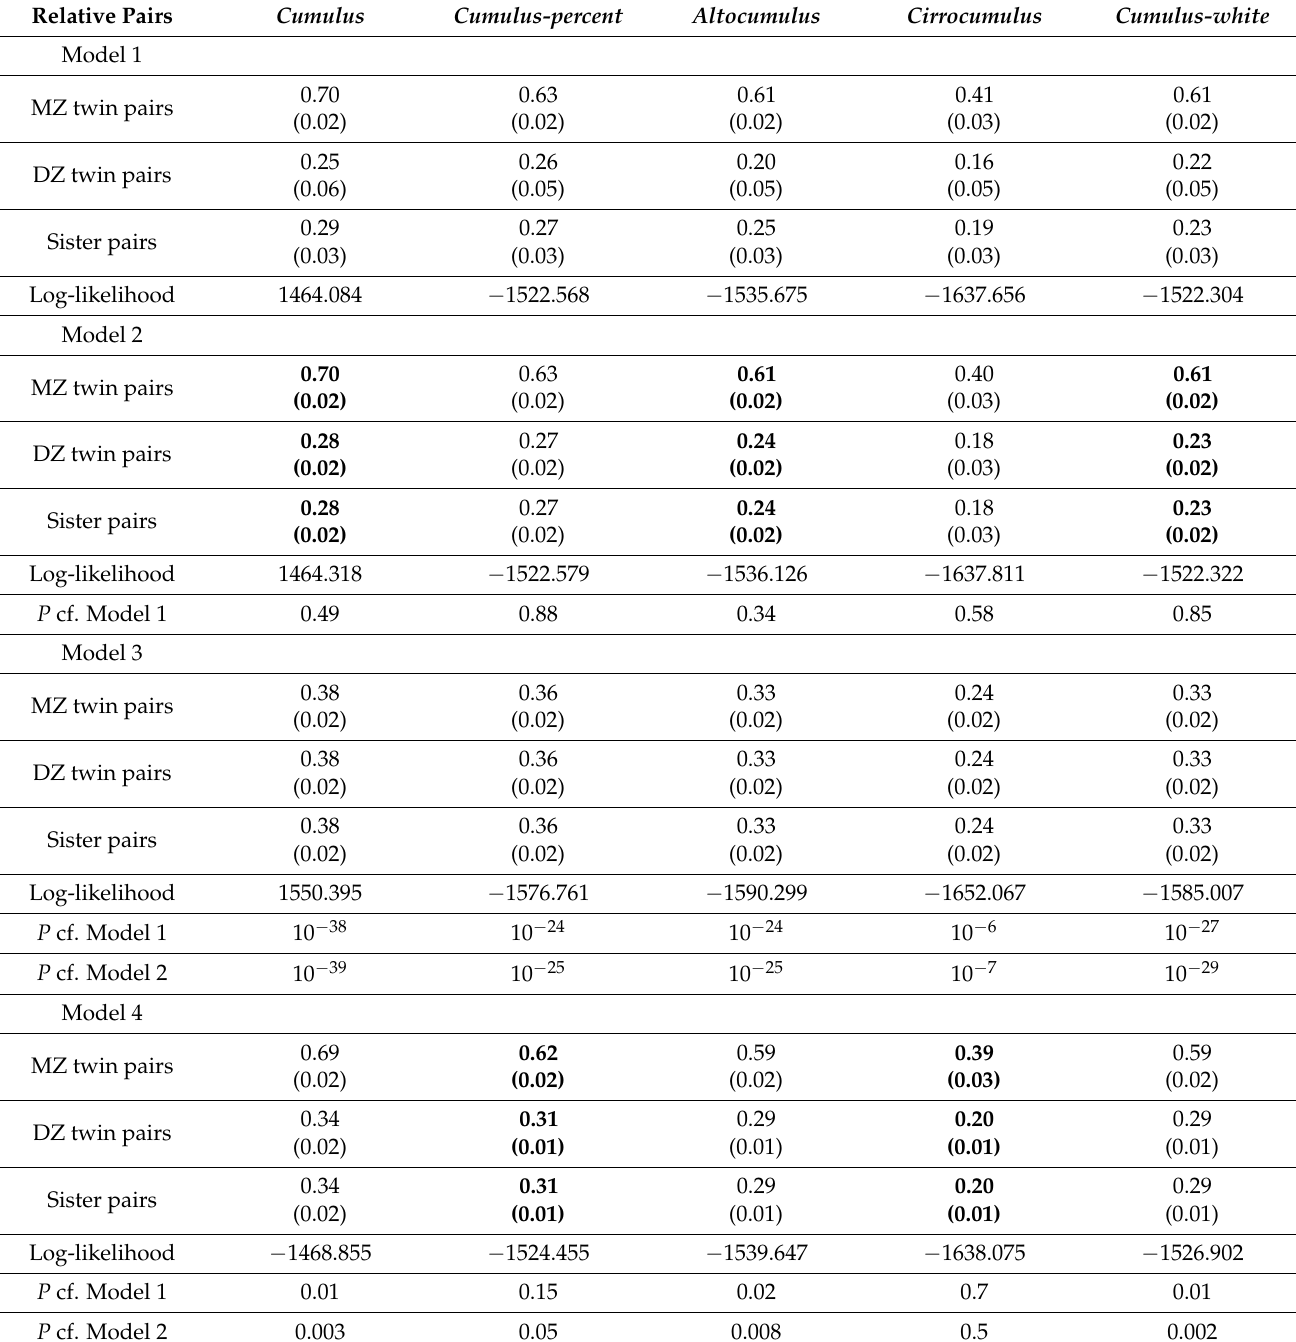
Table 2. Correlations in mammogram risk scores (standard errors in parentheses) for categories of relatives under unconstrained (model 1) and constrained models (model 2: DZ = sister; model 3: MZ = DZ = sister; model 4: DZ = sister = 0.5MZ) with p -value for designated comparison of model fits based on